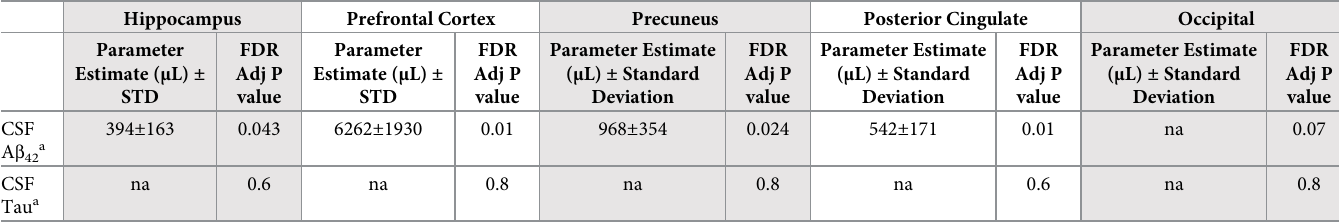
Table 1. Log CSF A β 42 and Tau predicting regional brain volumes adjusted for age, sex, scanner type and intracranial volume.